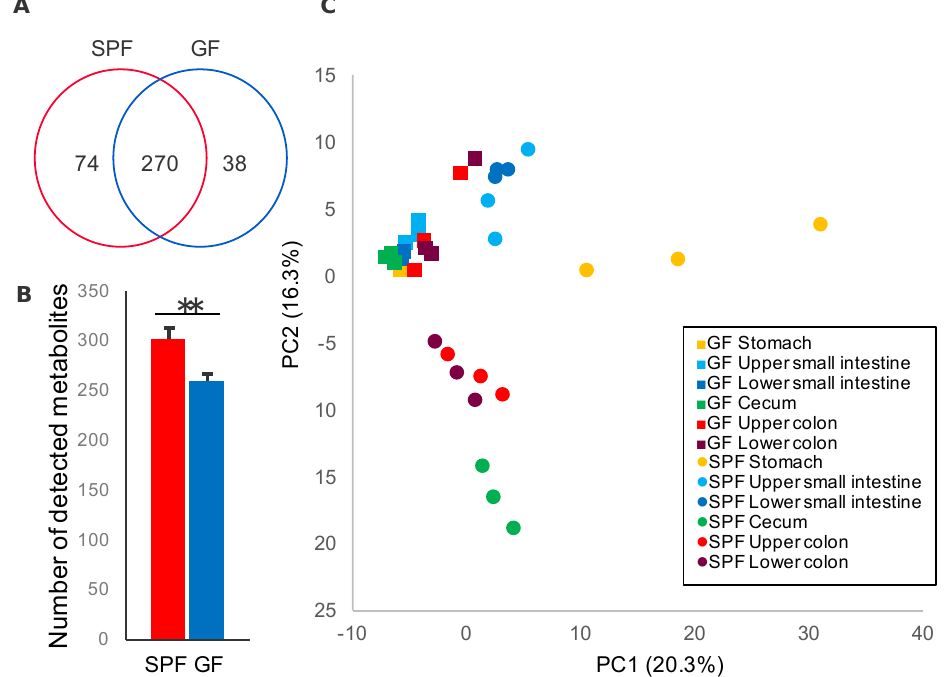
Figure 1. Gastrointestinal luminal metabolome profiles of specific pathogen-free (SPF) and germ-free (GF) mice. ( A ) Venn diagram showing the total number of gastrointestinal luminal metabolites